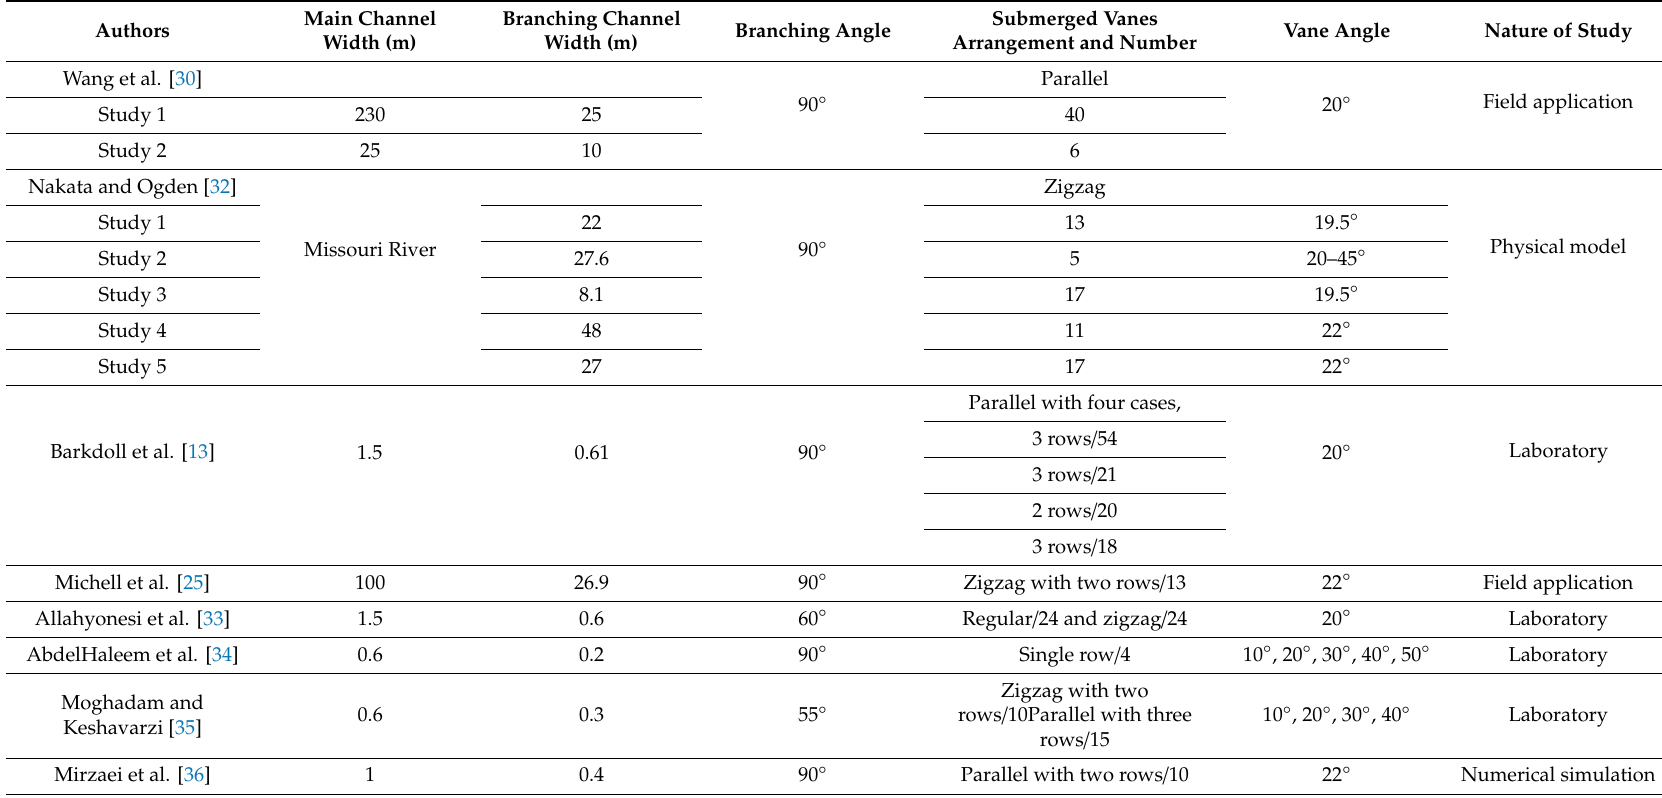
Table 1. Summary of the studies that used submerged vanes for controlling sediment dynamics at branching